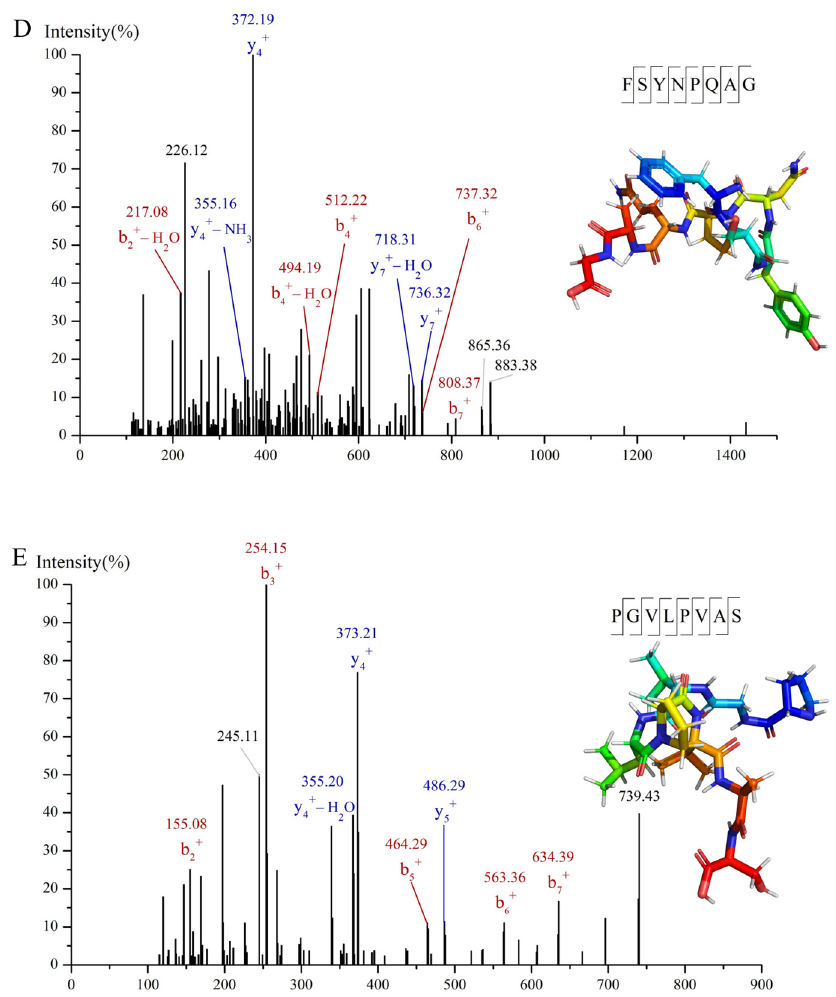
Figure 3. Total ion chromatogram of C-I ( A ) and MS/MS spectrum of FFVPPSQQ ( B ), FYNPAAGR ( C ), FSYNPQAG ( D ), and PGVLPVAS ( E ).